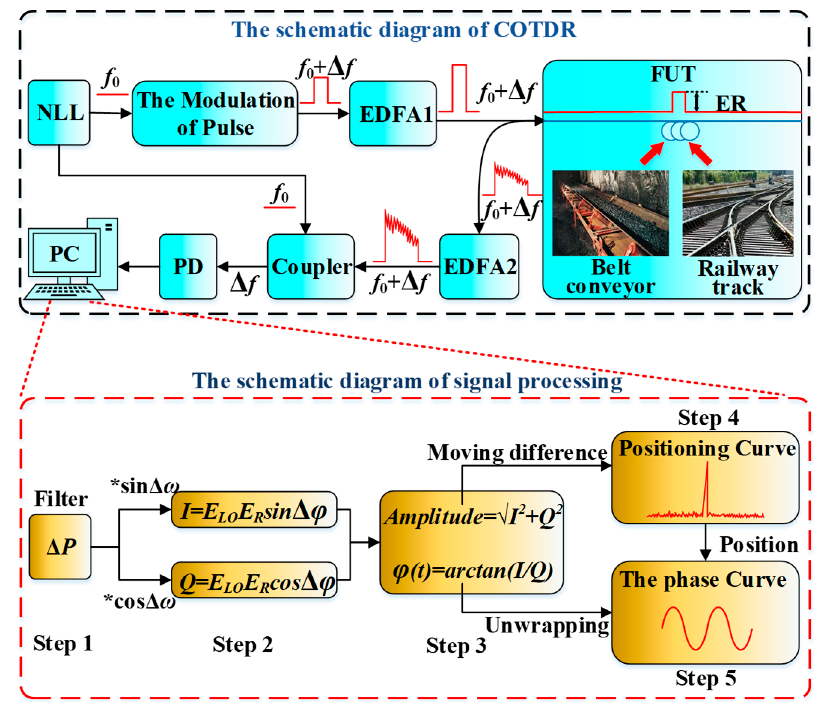
Figure 4. Signal demodulation schematic diagram of COTDR system.